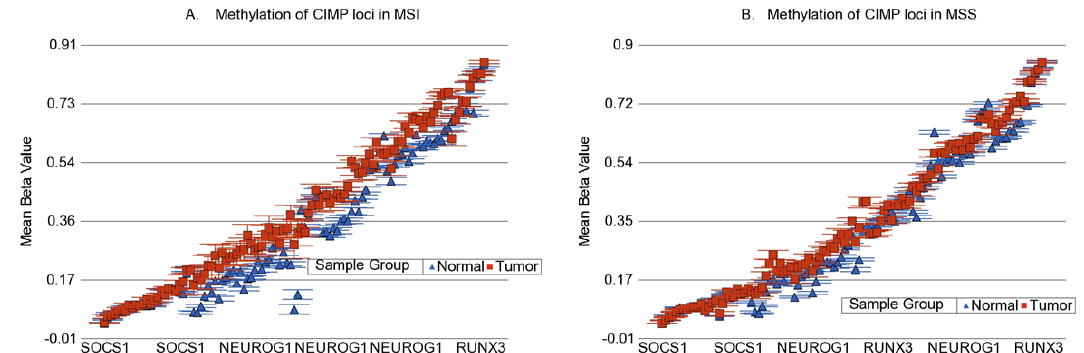
Figure 6. Methylation status of CIMP genes in the tumor (red) and normal (blue) in MSI and MSS. All 107 loci covering these genes commonly used for the detection of CIMP phenotype are shown. Changes in the MSI and MSS are shown in A and B respectively.